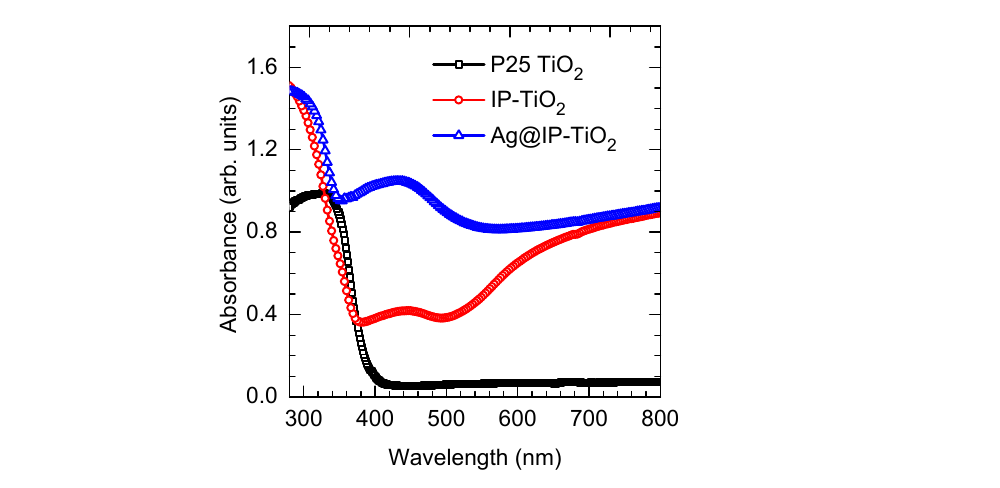
Figure 3. UV-VIS absorption spectra of P25 TiO 2 , IP-TiO 2 , and Ag@IP-TiO 2 .